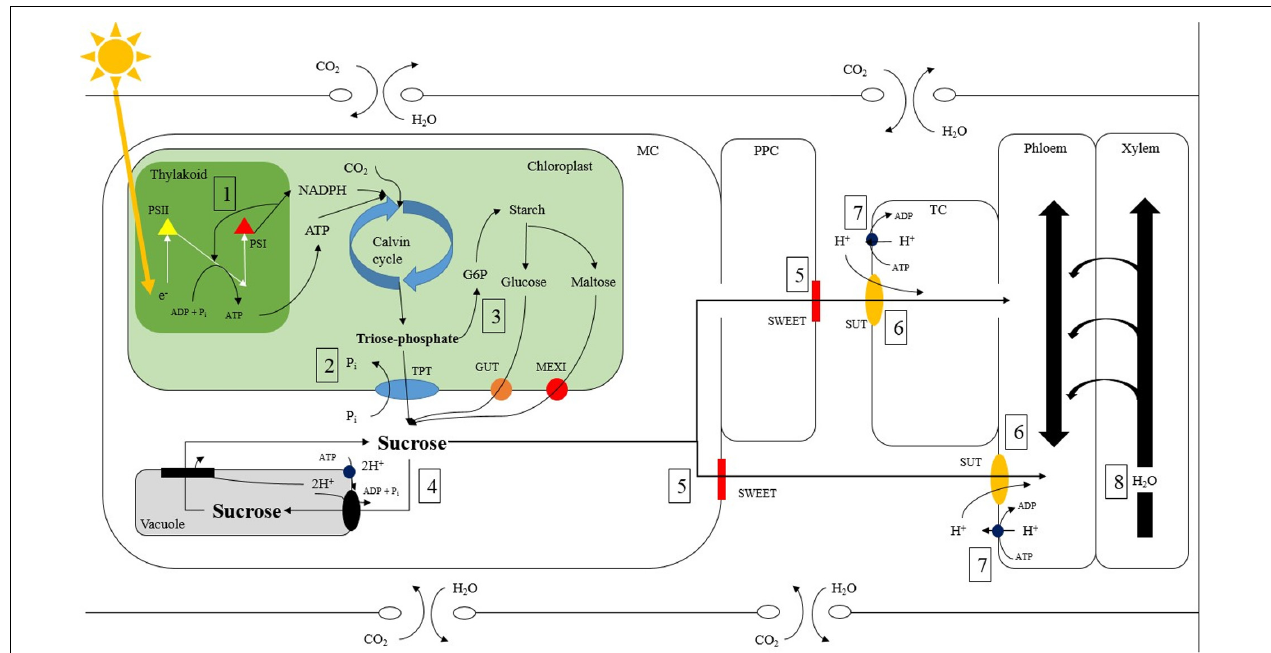
FIGURE 8 | Potential sites of carbon and water regulation which can be affected by light intensity and quality within a tomato source leaf. ATP is produced via the light reactions through the movement of electrons between photosystem II (yellow triangle) and photosystem I (red triangle) allows for the conversion of CO 2 to triose phosphate via the Calvin cycle (1) . Triose phosphate is then moved out of the chloroplast into the mesophyll cell (MC) via the anti-port mechanism of the triose phosphate/phosphate translocator (TPT; blue oval) where it is converted to sucrose ( 2 ; Stitt et al., 1987; Huber and Huber, 1990a; Walters et al., 2004). Triose phosphate can also be made into starch in a multiple step process. Starch, which is a storage molecule in tomatoes, can be broken down into either maltose or glucose and transported into the MC via a maltose excess1 transporter (MEXI; red circle) or glucose transporter (GUT; orange circle) respectively ( 3 ; Schleucher et al., 1998; Niittylä et al., 2004). Both maltose and glucose can then be converted to sucrose in the MC. Sucrose is then able to proceed via multiple pathways. Sucrose can enter the vacuole via an anti-port tonoplast membrane located H + /sucrose transporter (black oval) and conversely leave the vacuole via a tonoplast membrane located H + /sucrose symport (black rectangle) ( 4 ; Schulz et al., 2011; Etxeberria et al., 2012). Sucrose can also move into the apoplast via the ‘sugars will eventually be exported transporter’ (SWEET; red rectangle) directly from the MC or by first symplastically diffusing into the phloem parenchyma cell (PPC) ( 5 ; Chen et al., 2012; Feng et al., 2015). The mechanism of sucrose efflux via SWEET is currently speculated to be bidirectional uniport, however lacks concrete evidence (Chen et al., 2015). Once in the apoplast, sucrose enters the phloem directly or the transfer cell (TC) then enters the phloem symplastically. Entering the phloem directly or the TC is catalyzed by a co-transport H + /sucrose transporter (SUT; orange oval) ( 6 ; Riesmeier et al., 1992). ATPase enzymes (dark blue circle) are responsible for maintaining H + gradients across membranes and are usually found close to enzymes using H + symport or anti-port mechanism (7) . The movement of water between the xylem and phloem has also been proposed to affect carbon export rates ( 8 ; Smith and Milburn, 1980; Windt et al., 2006; De Swaef et al., 2013; Nikinmaa et al.,